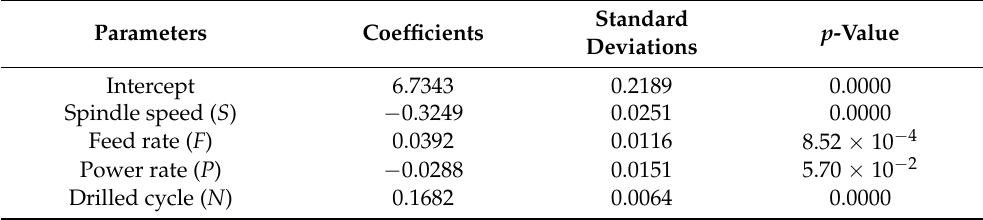
Table 7. Regression coefficients for the cutting force model in power-law